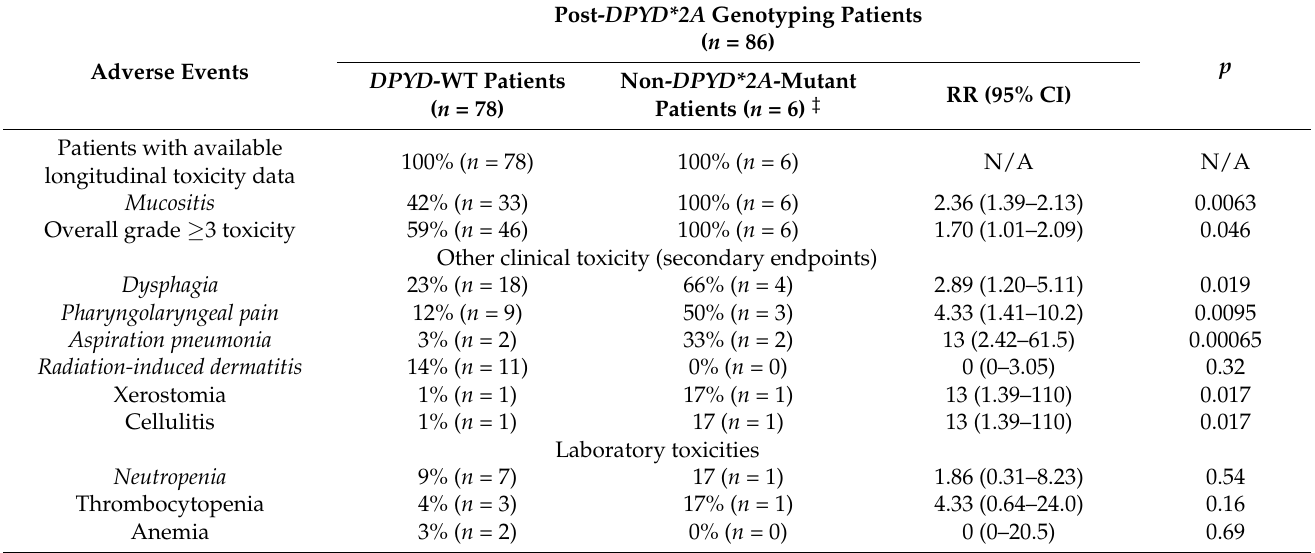
Table 3. Patient clinical and laboratory severe toxicities (grade ≥ 3) †